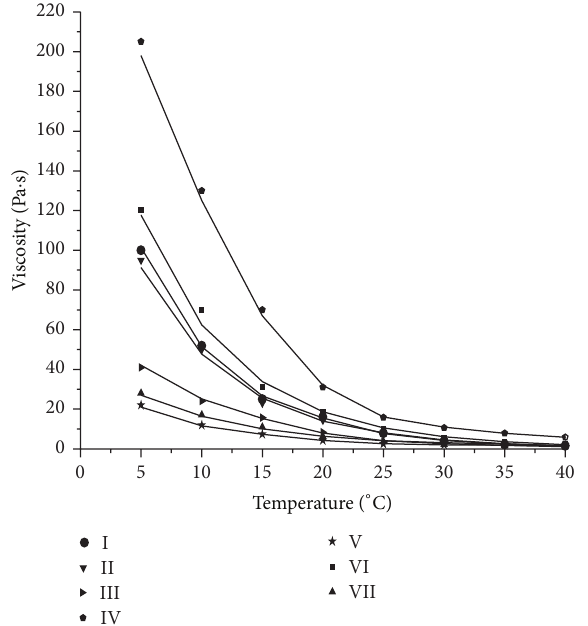
Figure 1: Effect of temperature on viscosity of different commercial Indian honey (I–VII).